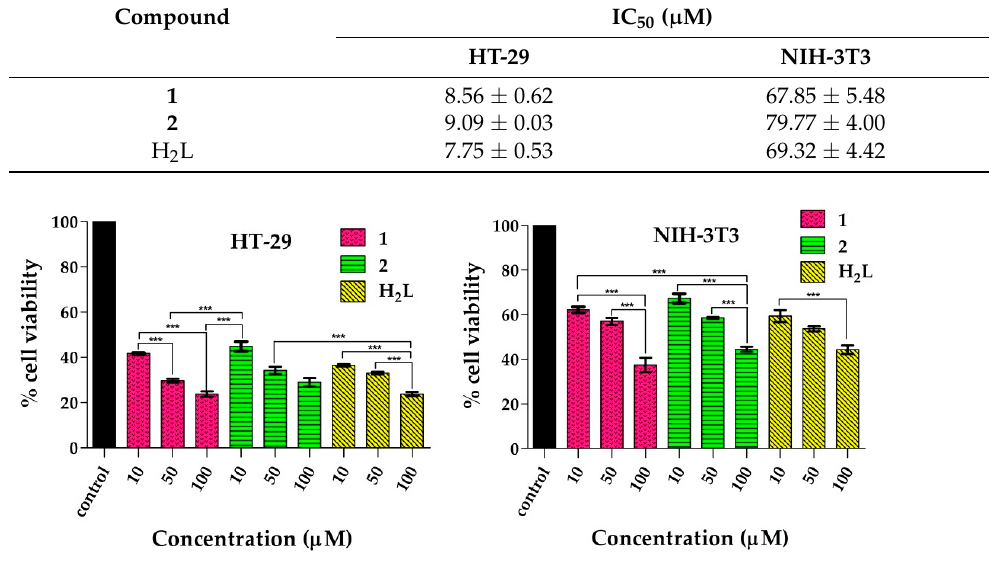
Figure 6. The effect of 1 , 2 , and H 2 L on the cell viability of HT-29 and NIH-3T3 cells after 48 h of exposure, taking 10, 50, and 100 μ M concentrations of the compounds. The cell viability was cal- culated by MTT assay. Data were reported as the mean ± SD for n = 4. *** p < 0.0001 was considered statistically significant. Table 4. IC 50 values of H 2 L and Complexes ( 1 and 2 ) taking 10, 50, and 100 μ M concentrations.